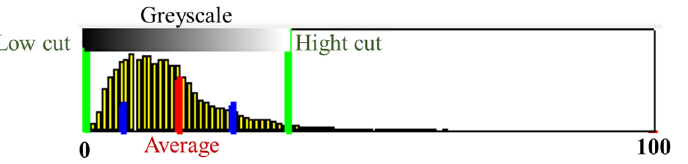
Figure 2. Illustration of the grayscale definition showing greyscale thresholding and transformation (captured from GPRSLICE).